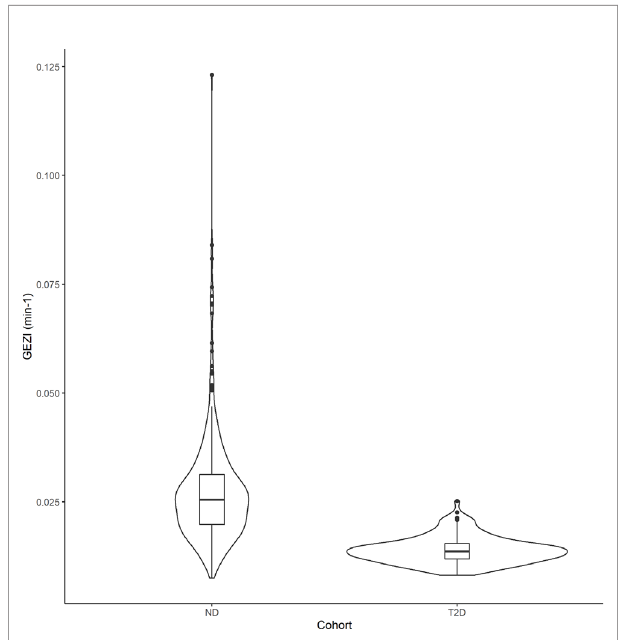
FIGURE 3 | Violin plots showing the distribution of the individual subjects conditional mean estimates of GEZI in the ND and T2D cohorts. Boxplots were inserted for each cohort to indicate medians and interquartile ranges.